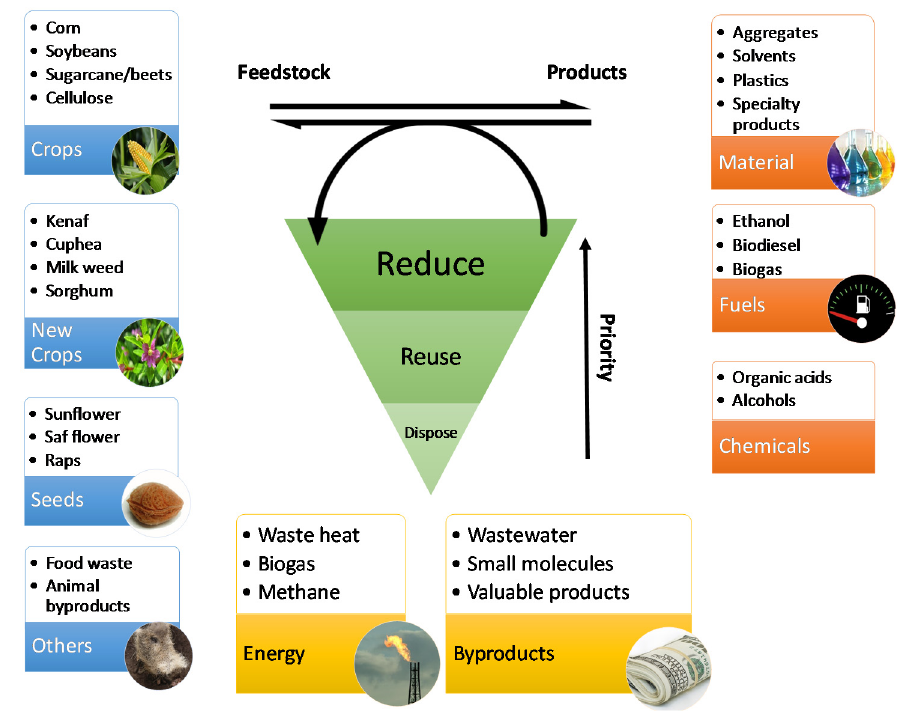
Figure 1. An overview of feedstock, typical products and waste generated from bio-based production processes. Waste reduction has priority over reuse/resource recovery, and disposal is the least preferable option.